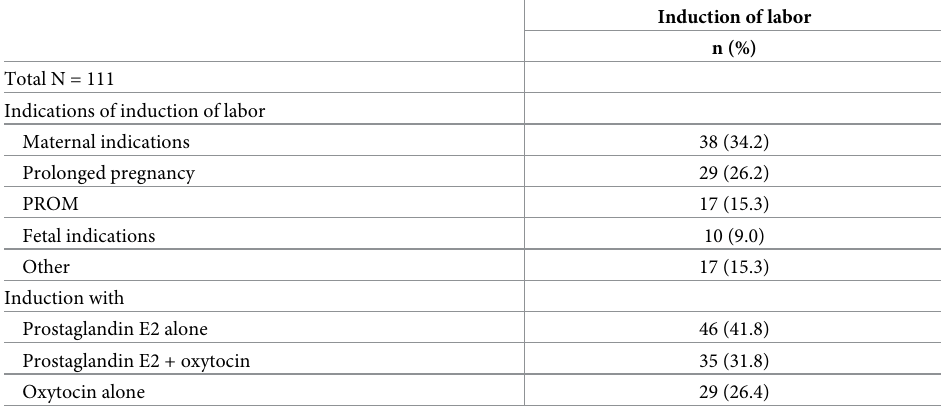
Table 2. Indications and methods used among women with induced labor.